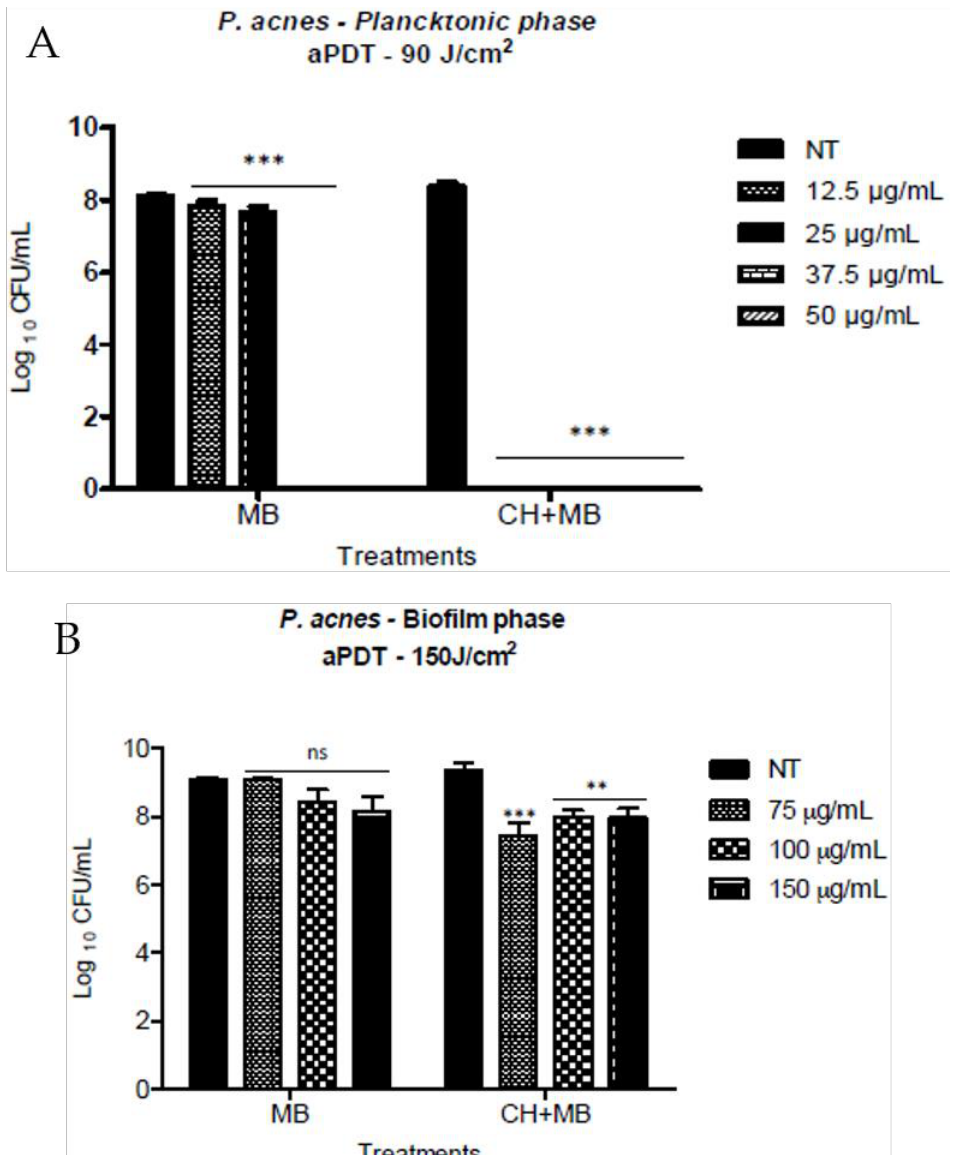
Figure 18. Antibacterial photodynamic therapy (aPDT) mediated by methylene blue (MB) in solution and by MB incorporated into 0.25 chitosan hydrogel over the standard suspension of P. acnes ( A ) or biofilm of P. acnes ( B ). Columns represent the average of three independent assays, and bars represent the standard deviation. The asterisks indicate where there is a statistical difference in comparison with the groups treated and the group non-treated (NT); (two-way ANOVA with posttest Bonferroni), ** p < 0.01; *** p < 0.001. Reprinted with permission. Copyright 2018, MDPI